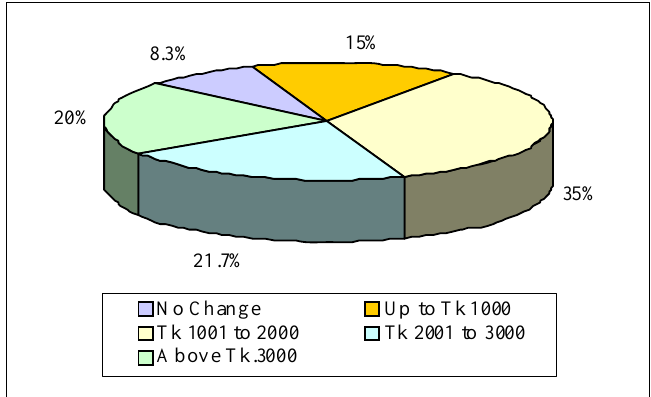
Figure 4. Distribution of households according to income change due to flood. Source: field survey. Climate 2016 , 4 , 60